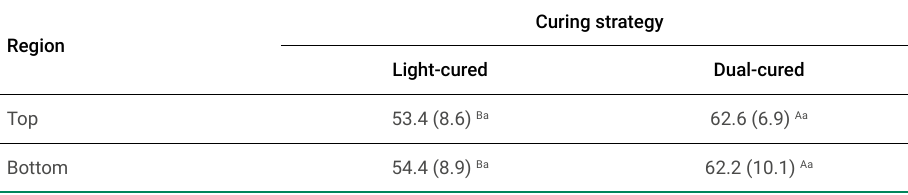
Table 2. Means (standard deviations) of in situ DC (%) according to the curing strategy of the adhesive system and specimen region. Curing strategy Region Light-cured Dual-cured Top 53.4 (8.6) Ba 62.6 (6.9) Aa Bottom 54.4 (8.9) Ba 62.2 (10.1) Aa Distinct uppercase letters indicate statistically significant differences between curing strategies for the same region (p<0.05). Distinct lowercase letters indicate statistically significant differences between regions for the curing strategy